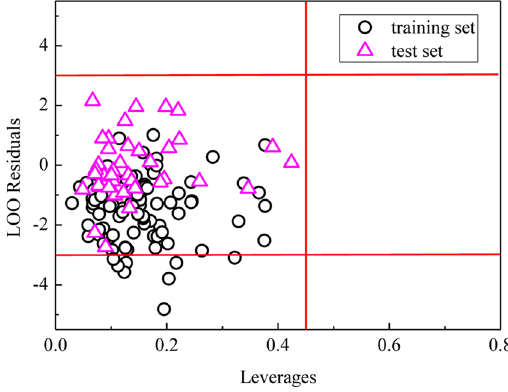
Figure 4. Williams plot of standardized residual versus leverage.